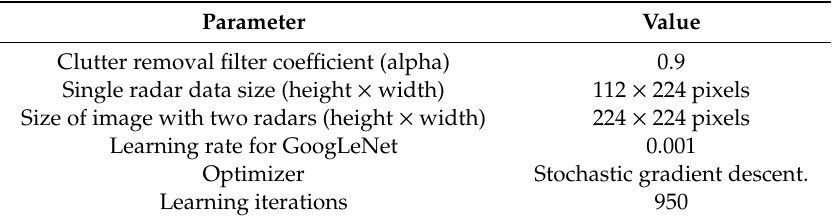
Table 2. Signal specification and hyper parameters of the classifier.